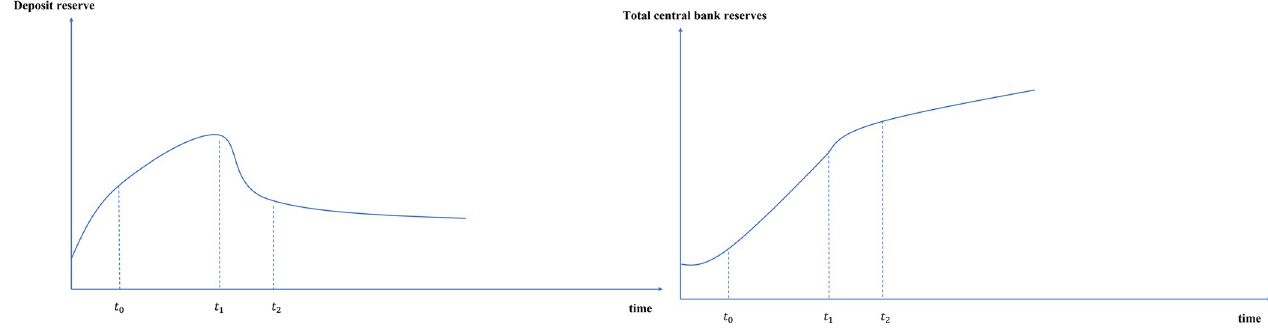
Fig 8. Path changes of the central bank reserve after e-CNY issuance.